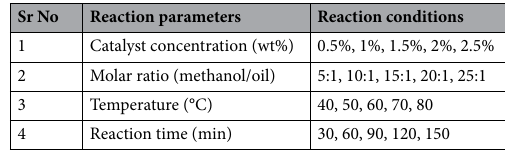
Table 1. Transesterification reaction